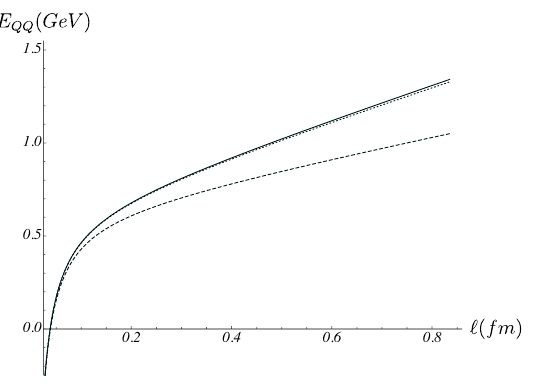
Figure 12 . Various E vs ‘ plots. The curves correspond to (3.37) (solid), (4.1) (dashed), QQ and (4.3)